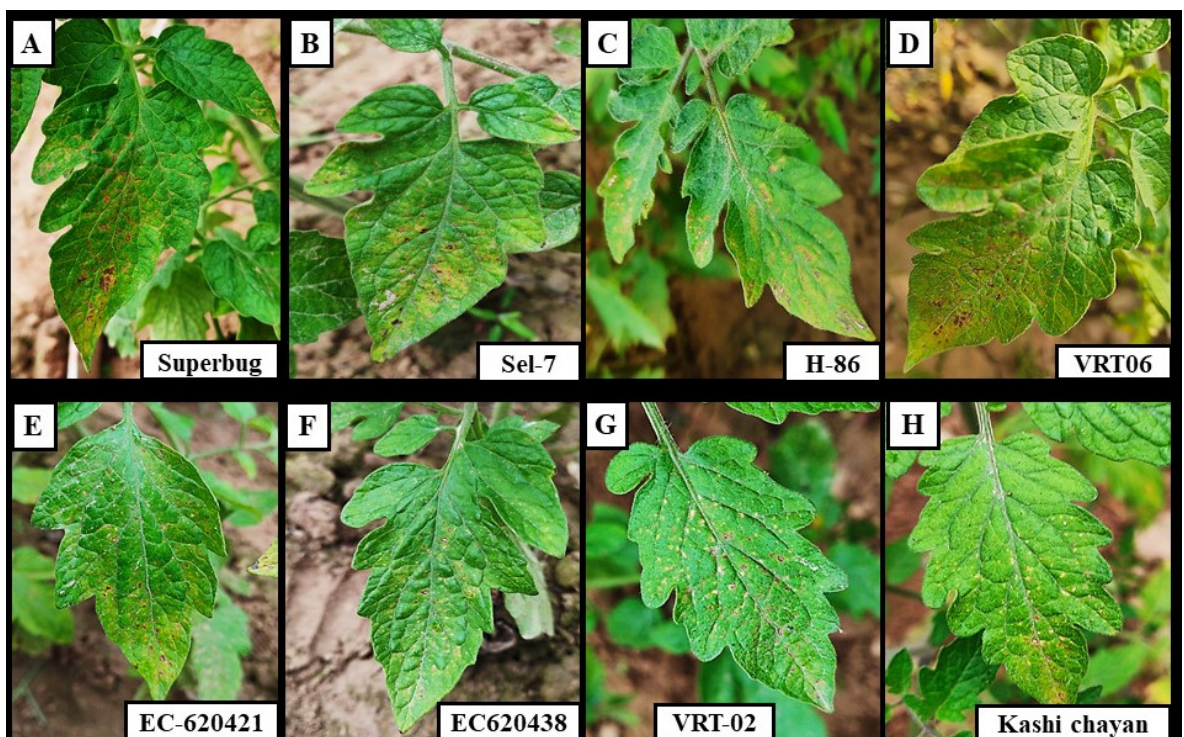
Figure 1. Foliar injury symptoms observed across the tomato cultivars in the form of flecking ( E– H ), interveinal chlorosis/bronzing ( A , B , D ), and stippling ( C ).